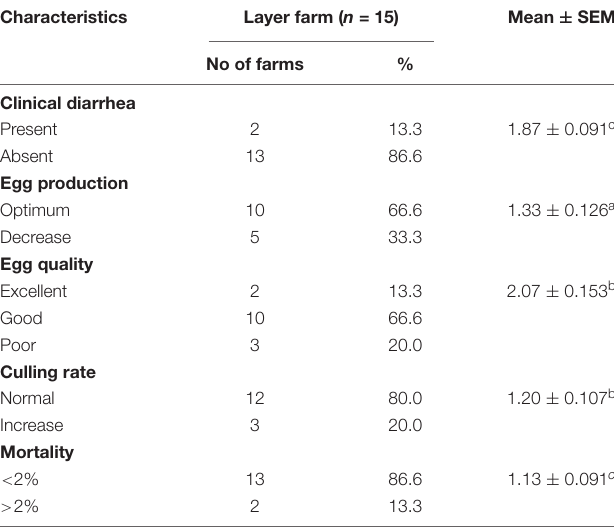
a Indicates p > 0.05 when compared with the production parameter of bird in the same column. b Indicates p < 0.05 when compared with the production parameter of bird in the same column. c Indicates p < 0.01 when compared with the production parameter in the same column. The data are expressed as the mean ±